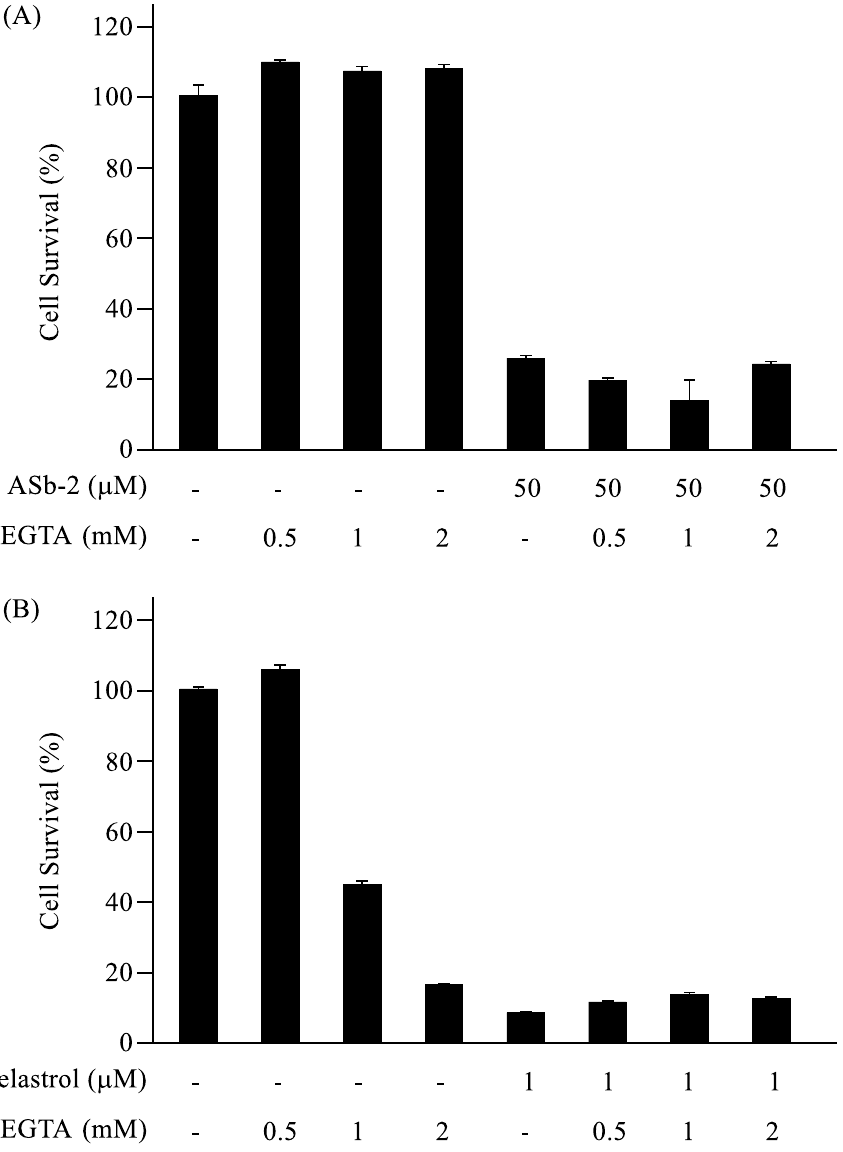
Figure 8. ( A ) The results of MTT assays of Jurkat cells treated with ASb-2 (50 µM) in the presence of EGTA (0.5, 1, and 2 mM) for 1 h at 37 °C. ( B ) The results of MTT assays of Jurkat cells treated with celastrol (1 µM) in the presence of EGTA (0.5, 1, and 2 mM) for 24 h at 37 °C. The changes in intracellular Ca 2+ concentrations induced by ASb-2 and celastrol were compared using a treatment with curcumin, a compound that is well known to induce apoptosis, with IC 50 values of 18 µ M and >100 µ M against Jurkat and IMR-90 cells, respectively (Figure 9A,B) [54]. It was found that curcumin induces cytosolic and mitochondrial Ca 2+ overload after incubation for 30–120 min, as shown in Figure 9C,D.